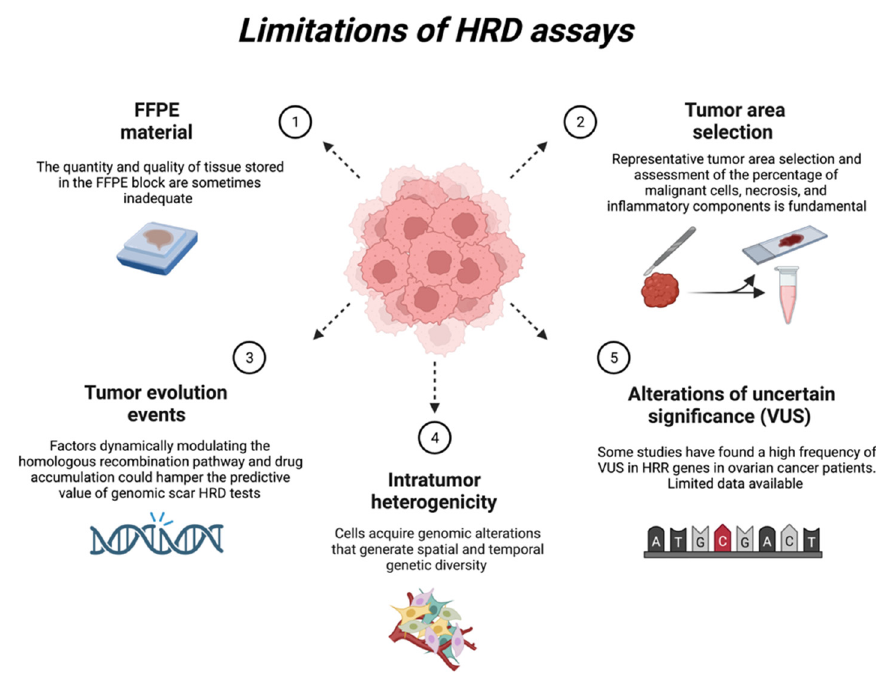
Figure 4. Current limitations of HRD tests. Created with BioRender.com.